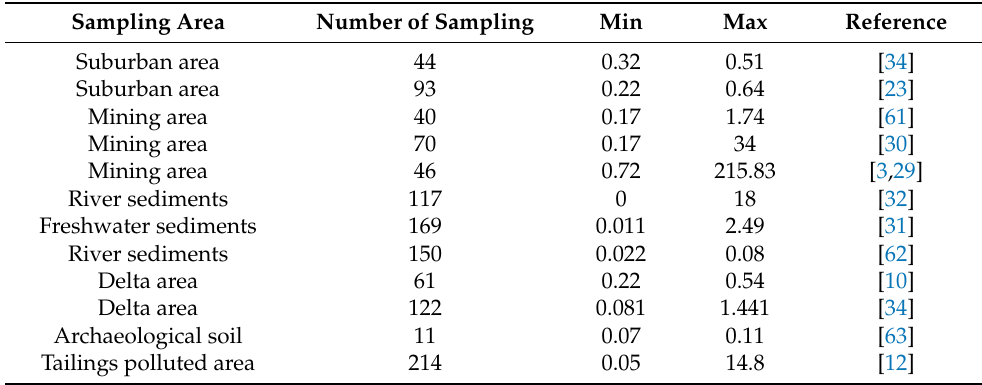
Table A2. Summary of Cd concentration in previous studies.